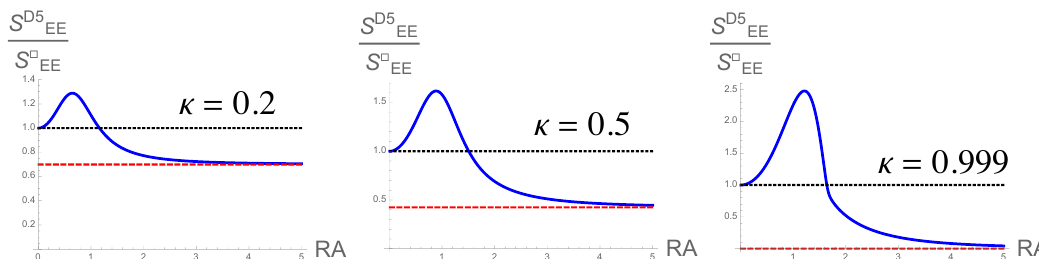
Figure 3 . The ratio of the EE contribution due to the D5-brane impurity (thick blue) and that of k fundamental quarks (dotted black line), as a function of the radius R of the spherical entangling region. The deformation A drives the (cid:13)ow and the dimensionless tunable parameter is RA . The red dashed line is the ratio S A = ( kS (cid:3) k